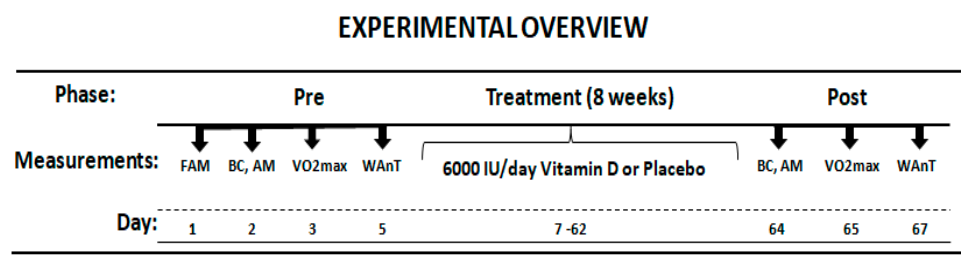
Figure 1. Experimental Overview.